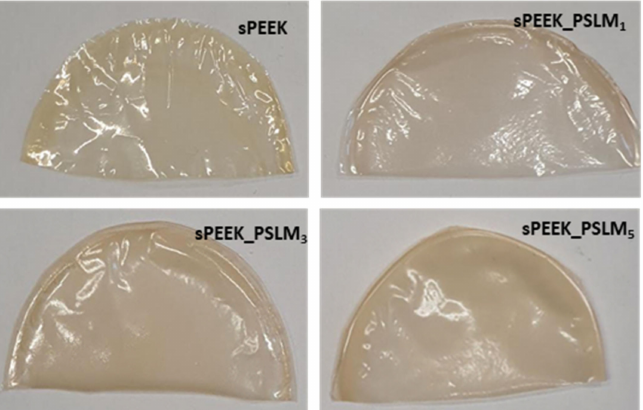
Figure 1. Pictures of pristine sPEEK and sPEEK_PSLM composites (at 1, 3, and 5% of filler loading)